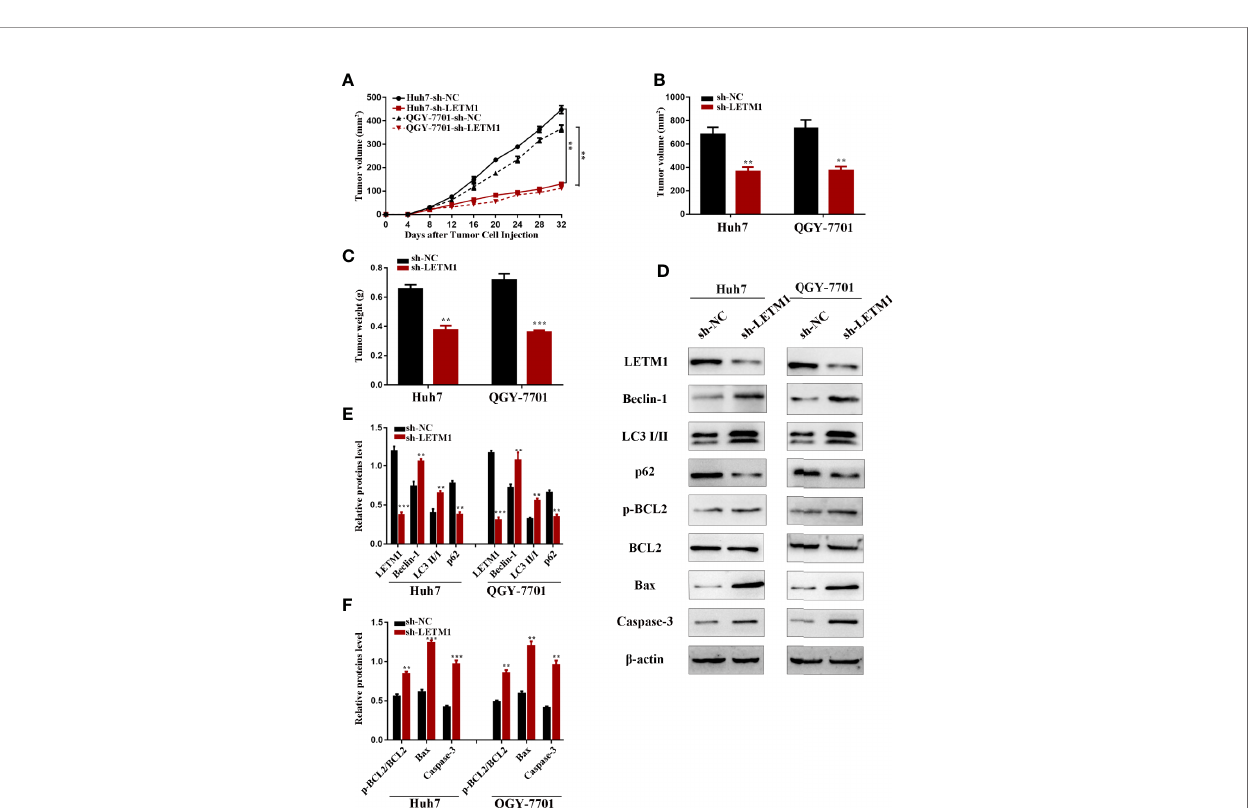
FIGURE 6 | LETM1 knockdown suppressed tumorigenicity of Huh7 and QGY-7701 cells in vivo . (A) The growth curve of the in vivo tumorigenicity assa in LETM1 knockdown Huh7 and QGY-7701 cells transfected nude mice (N=6/per group). (B) The weight of tumors in LETM1 knockdown Huh7 and QGY-7701 cells transfected nude mice (N=6/per group). (C) The volume of tumors in LETM1 knockdown Huh7 and QGY-7701 cells transfected nude mice (N=6/per group). (D – F) The protein level of autophagic associated proteins (Beclin1, p62, and LC3), apoptotic-related proteins (p-Bcl-2, Bcl-2, Bax, caspase-3) and LETM1 in tumor tissues of mice. ** p < 0.01, *** p < 0.001 versus sh-NC